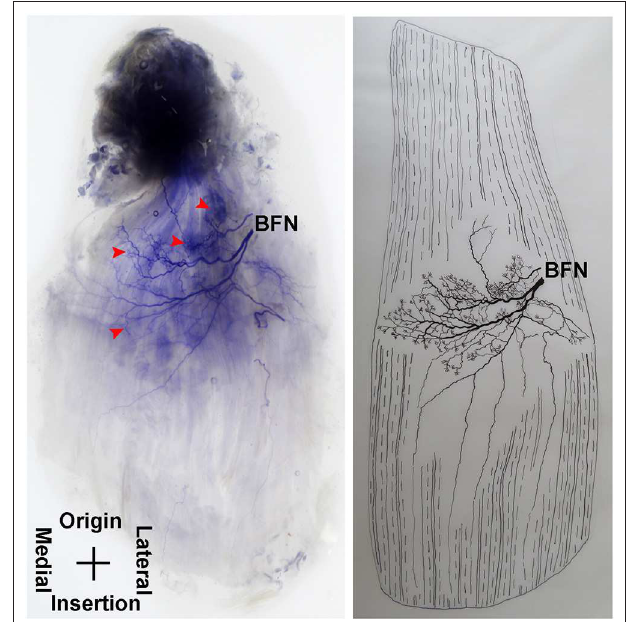
FIGURE 9 | Distribution of intramuscular nerves in the pectineus (right, superficial side). The arrowhead indicates the tree-like terminal nerve distribution (BFN, branch of the femoral